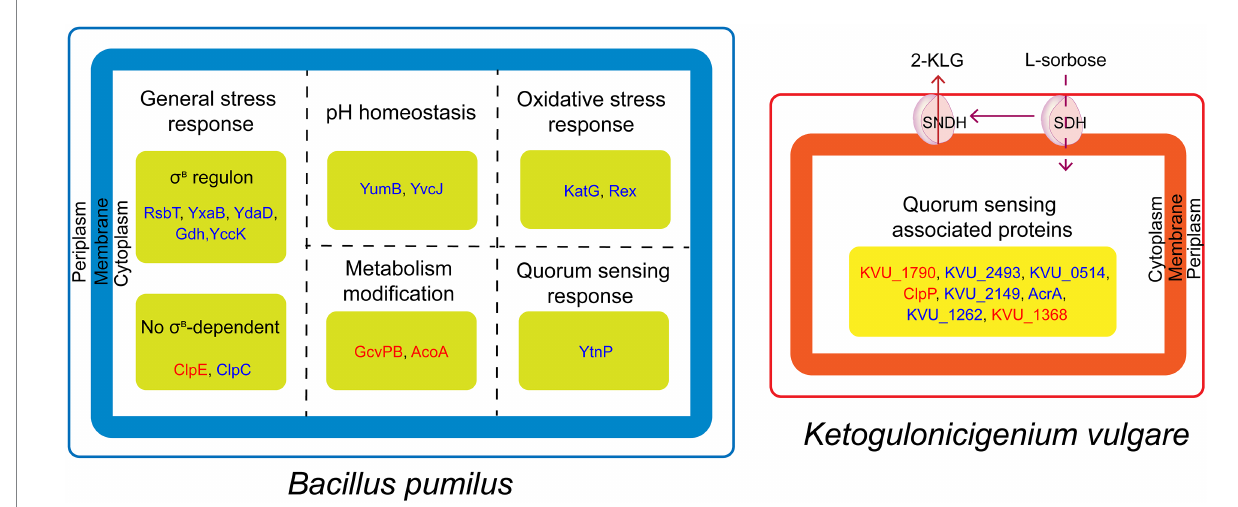
FIGURE 5 Schematic representation of antagonistic mechanism between B. pumilus and K. vulgare . K. vulgare produce 2-KLG and quorum sensing associated virulence factors against B. pumilus , whereas, B. pumilus produce proteins in response to acid stress and quorum sensing. The red and blue fonts represent upregulated and downregulated proteins,